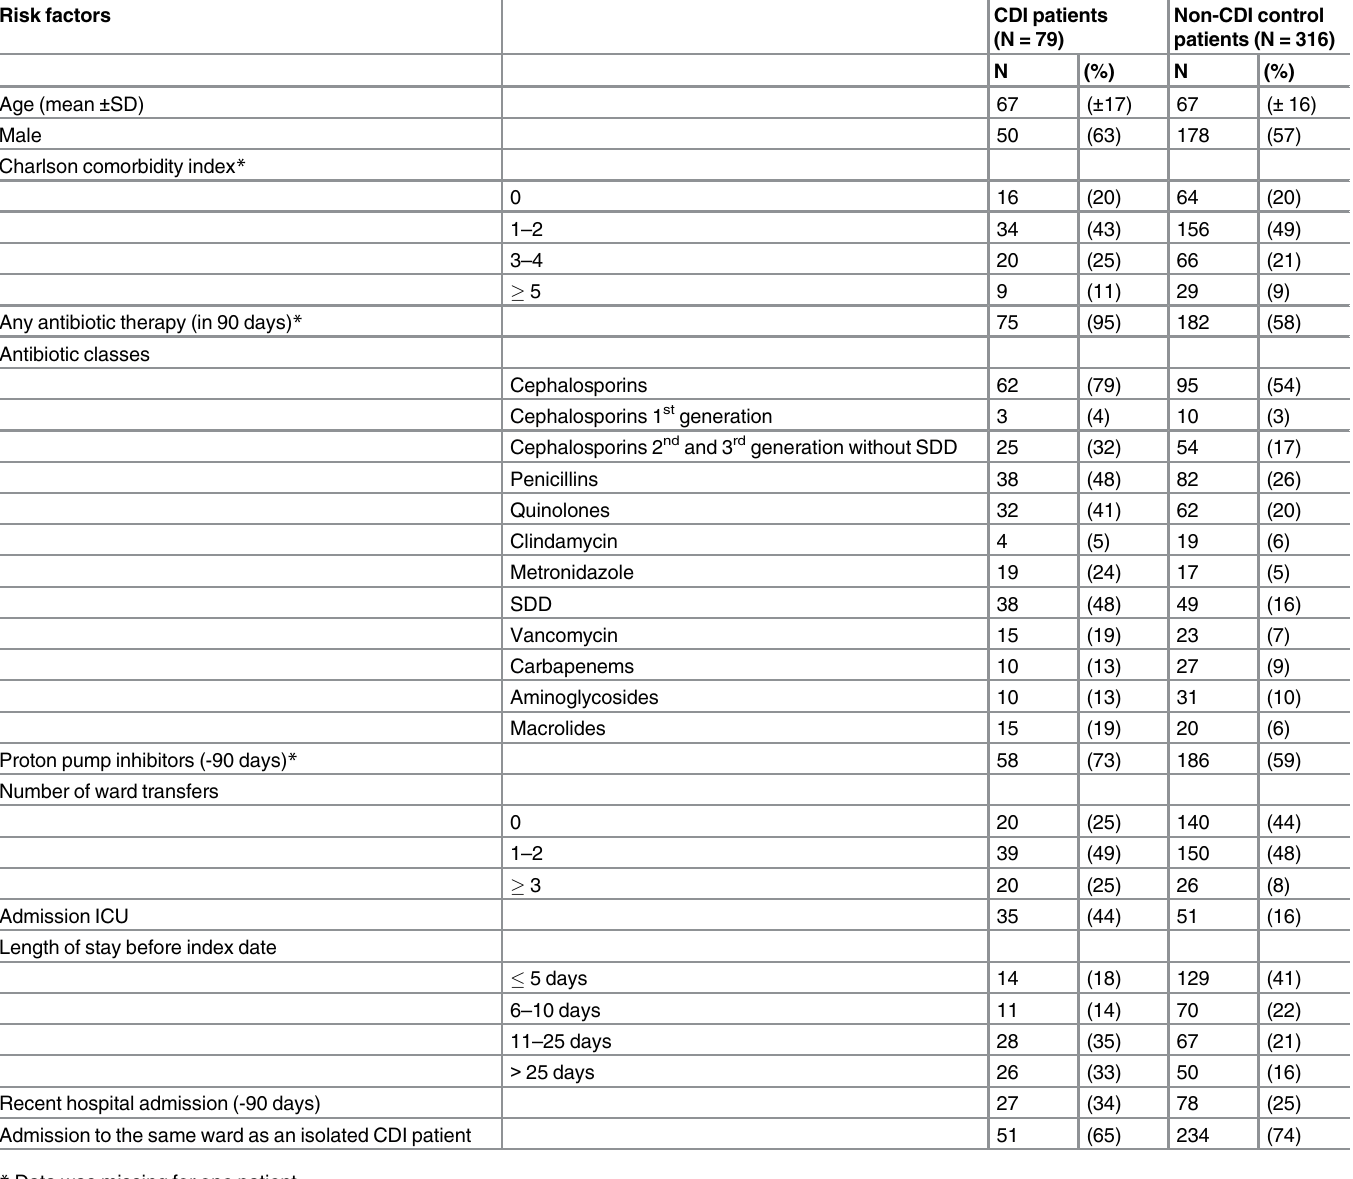
Table 1. Patient characteristics of patients with CDI and control